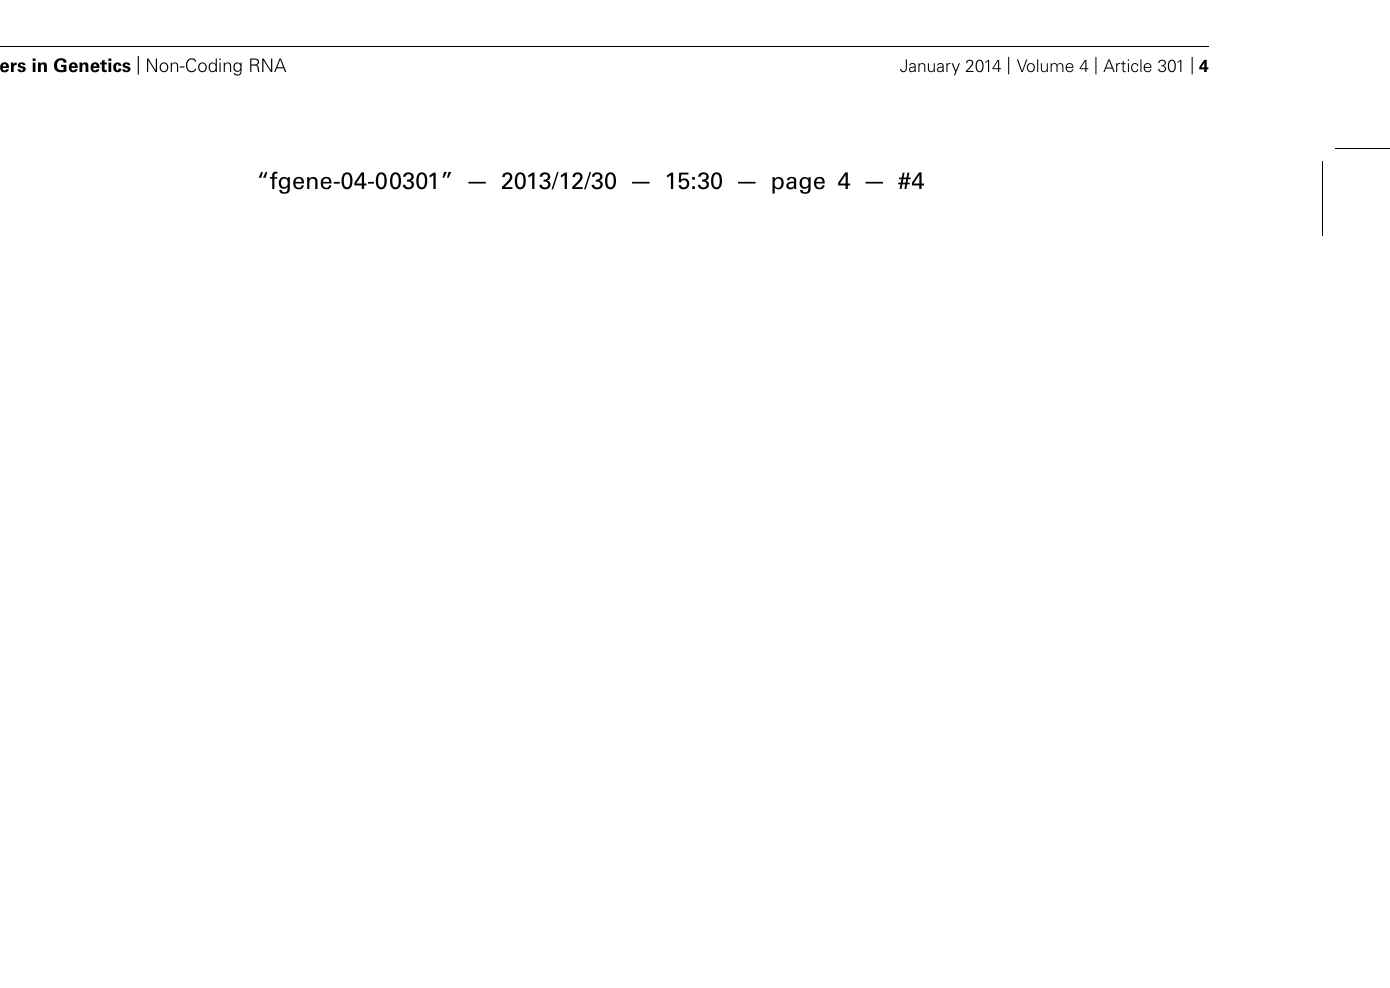
FIGURE 1 | Effect of anti-miR21 on miR21 activity. (A) Bright field images of HCT116-GFP cells that were transfected with anti-miR21 or control siRNA and grown for the indicated times. (B) left , confocal microscopy image of HCT116-GFP cell 48 h after transfection with anti-miR21. Hoechst33342 stain (blue) indicates nuclei. right , confocal microscopy image of HCT116-GFP cell 48 h after transfection with control siRNA. (C) Relative GFP fluorescence of HCT116-GFP cells transfected with anti-miR21 (0.001–10 nM). Values represent mean ± SD ( n = 3) from three independent experiments. (D) Quantitative GFP mRNA levels (normalized